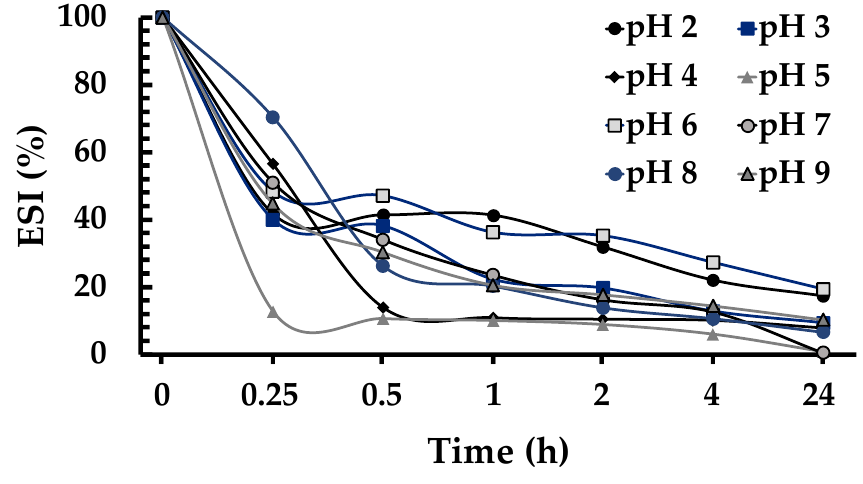
Figure 9. Emulsifying stability index of Ah11Sn.